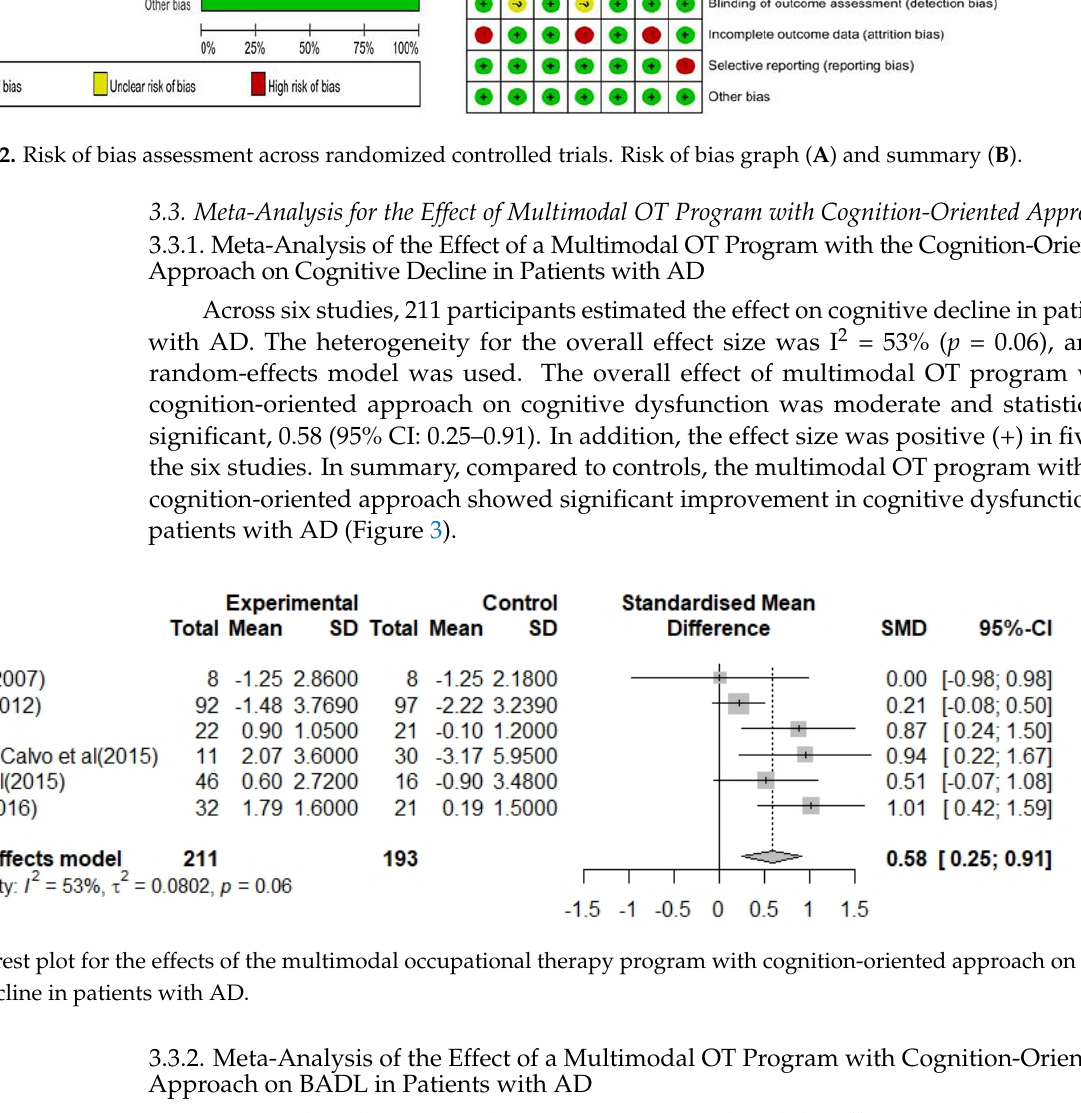
Figure 2. Risk of bias assessment across randomized controlled trials. Risk of bias graph ( A ) and summary ( B ).